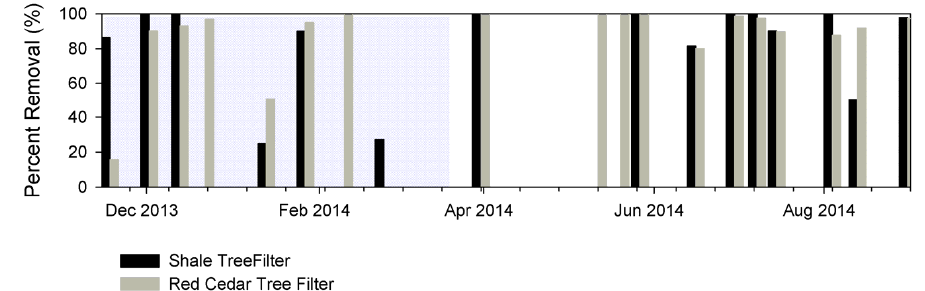
Figure 4. Comparison of E. coli removal percentages achieved by the two different filter units over the course of the sampling period. The gray area indicates the period during which snow was present and therefore the influent consisted of a combination of runoff and snowmelt.